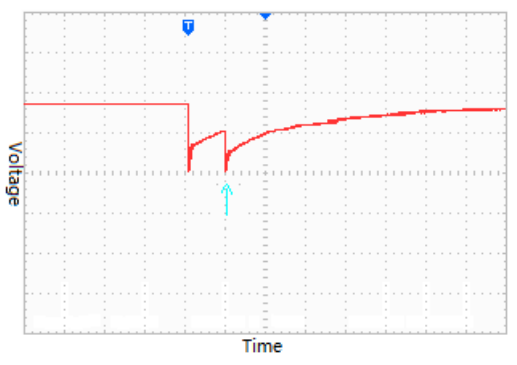
Figure 9. Pulse amplification wave of false triggering.